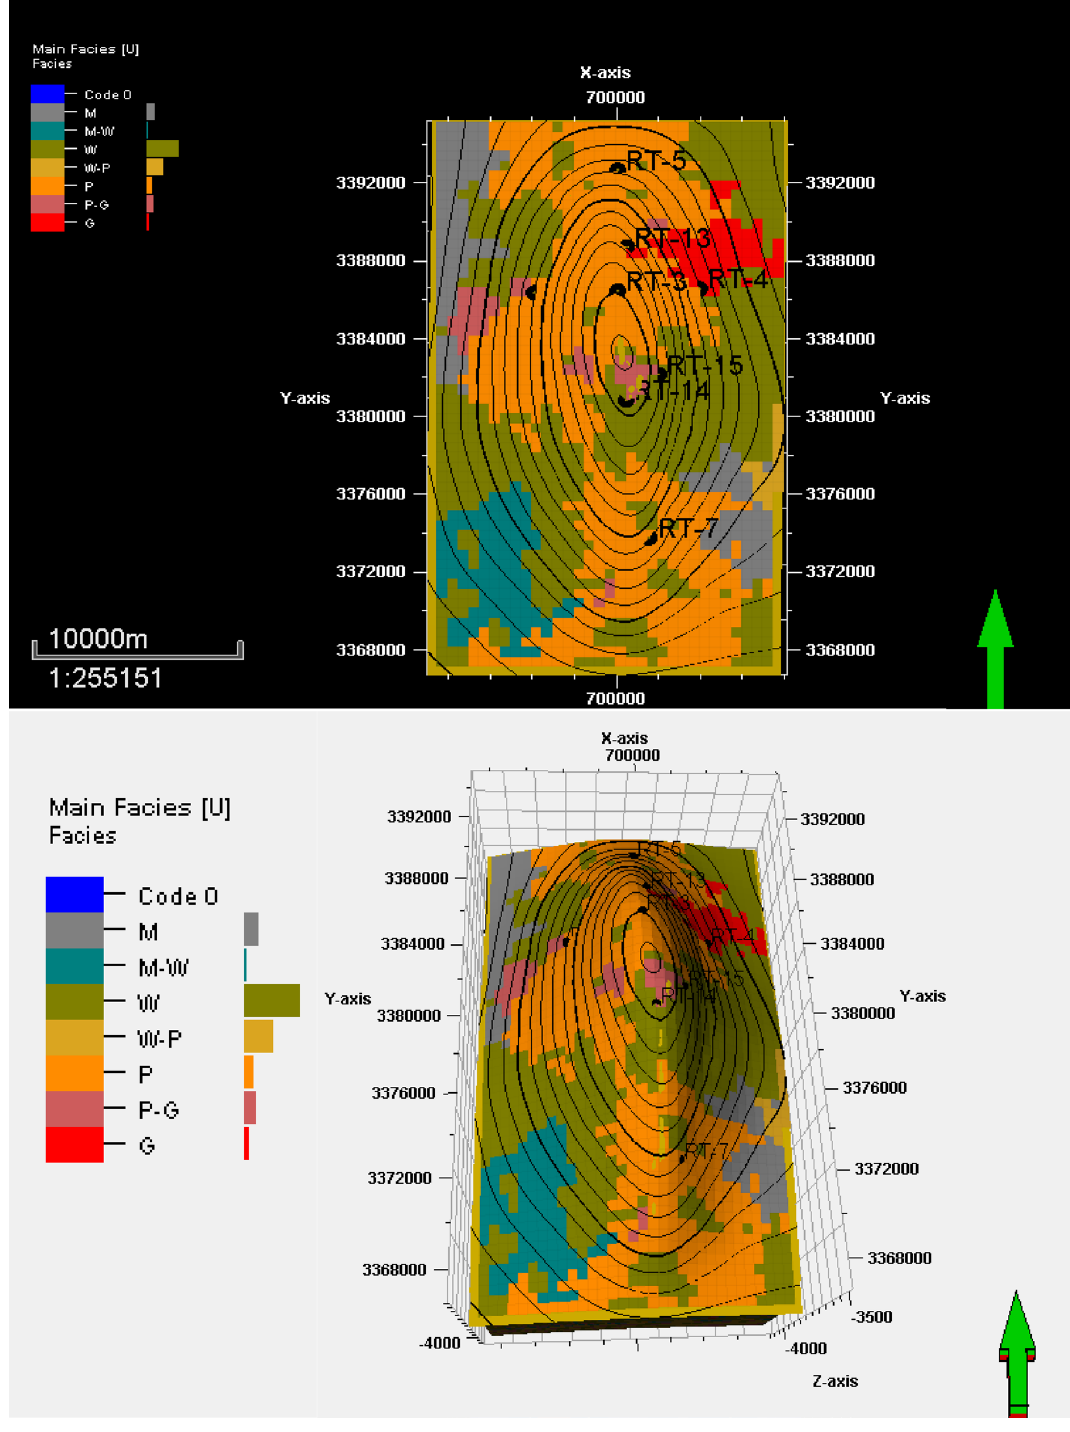
Figure 9. Facies distribution of the top surface of reservoir unit